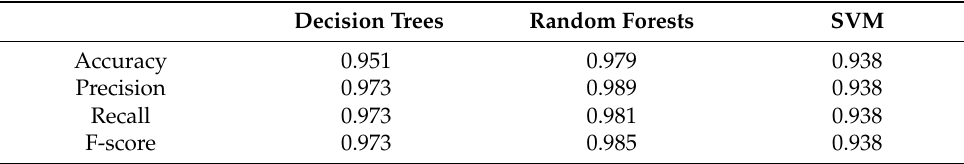
Table 5. Road traffic conditions classification results.